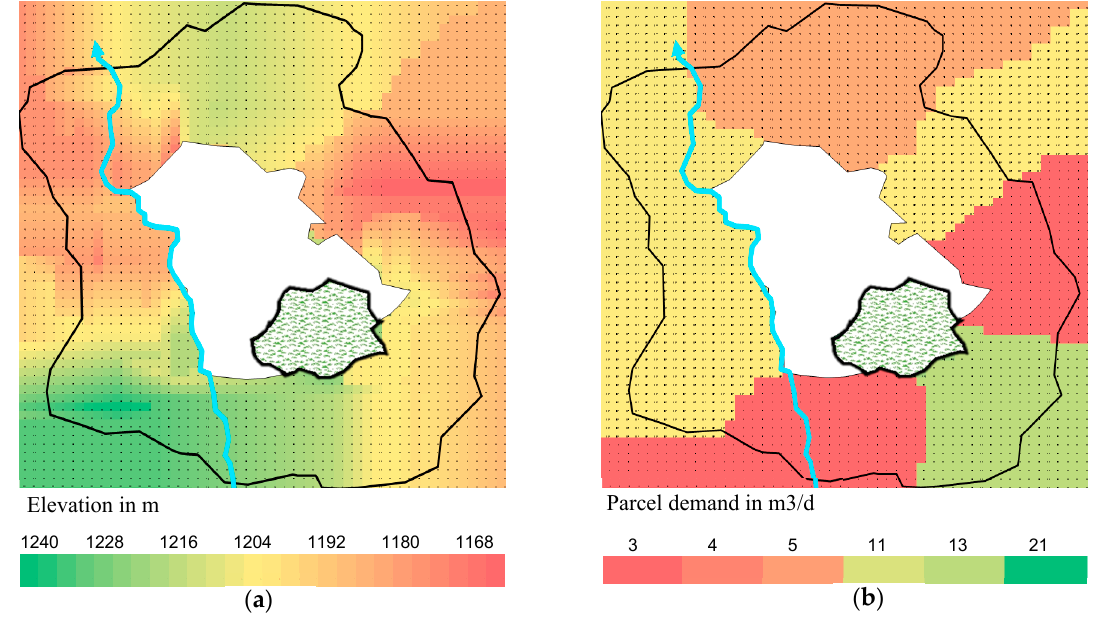
Figure 9. Maps showing elevation in m (asl) in the study area ( a ) and parcel water demand in m 3 / d ( b ).